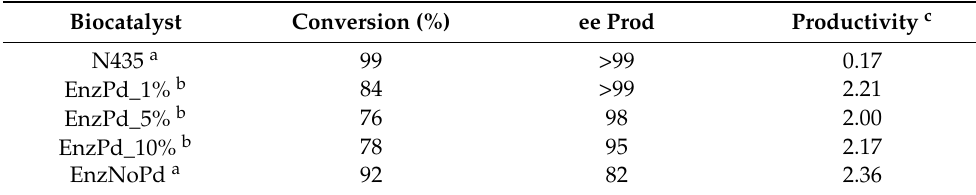
Table 4. Dynamic kinetic resolution of α -methylbenzylamine catalyzed by hybrid catalyst.